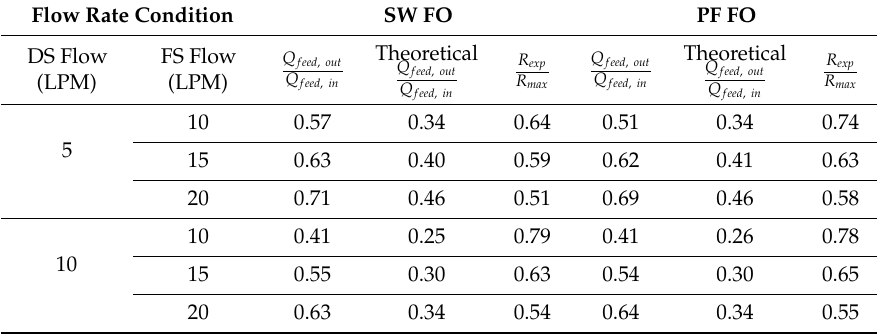
Table 3. Summary of FO performance for spiral-wound (SW) and plate-and-frame (PF) forward osmoses (FO) modules under di ff erent feed solution (FS) and draw solution (DS) flow rates conditions. Experimental normalized feed flow volume at outlet: Q feed, out / Q feed, in ; theoretical minimum normalized feed flow volume at outlet: theoretical Q feed, out / Q feed, in ; FO performance e ffi ciency: R exp / R max . Three SW FO elements (45.9 m 2 ) and six PF FO elements (42 m 2 ) were used. The concentrations of FS and DS were 10 and 70 g / L,